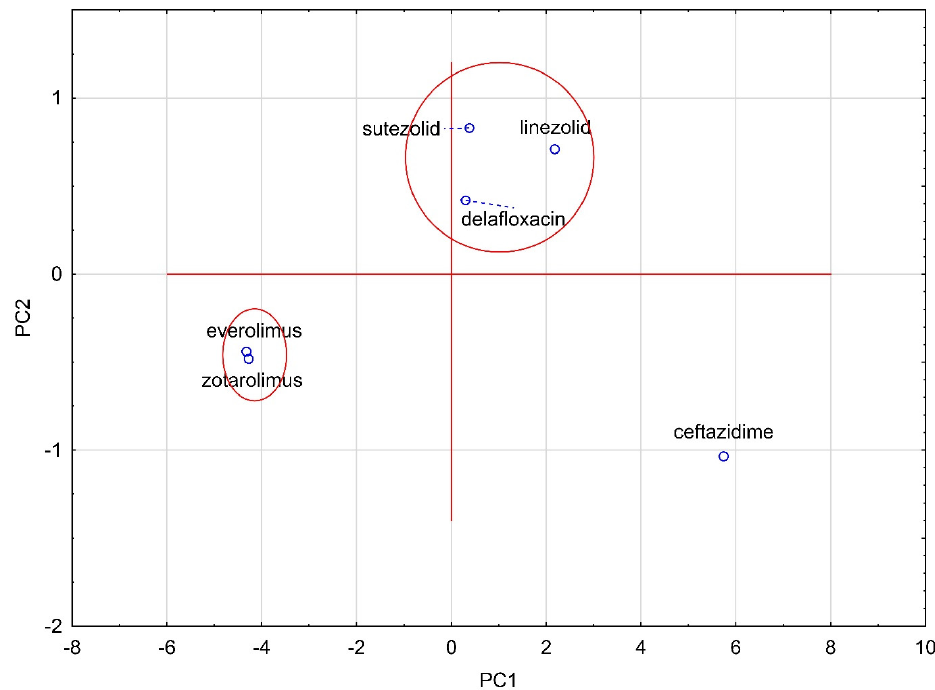
Figure 4. Plot of case projections on the plane of factors for analyzed compounds.